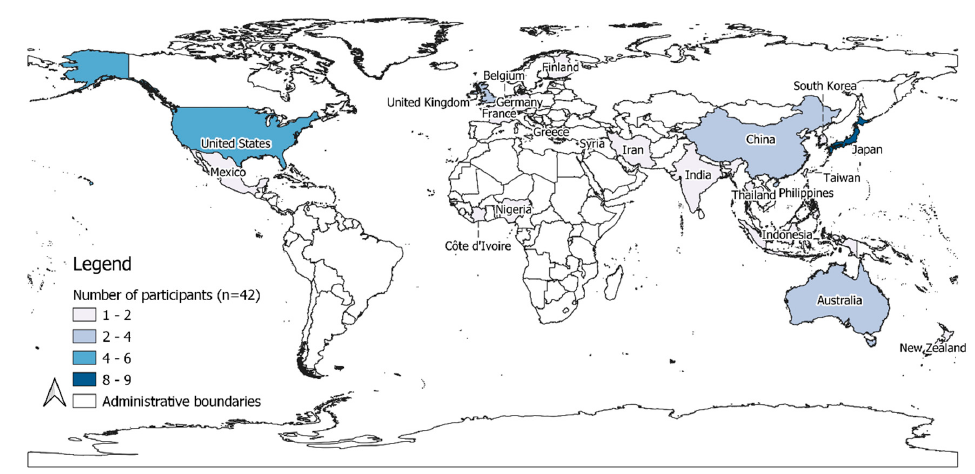
Figure 1. Participants ( n = 42) by country of nationality.